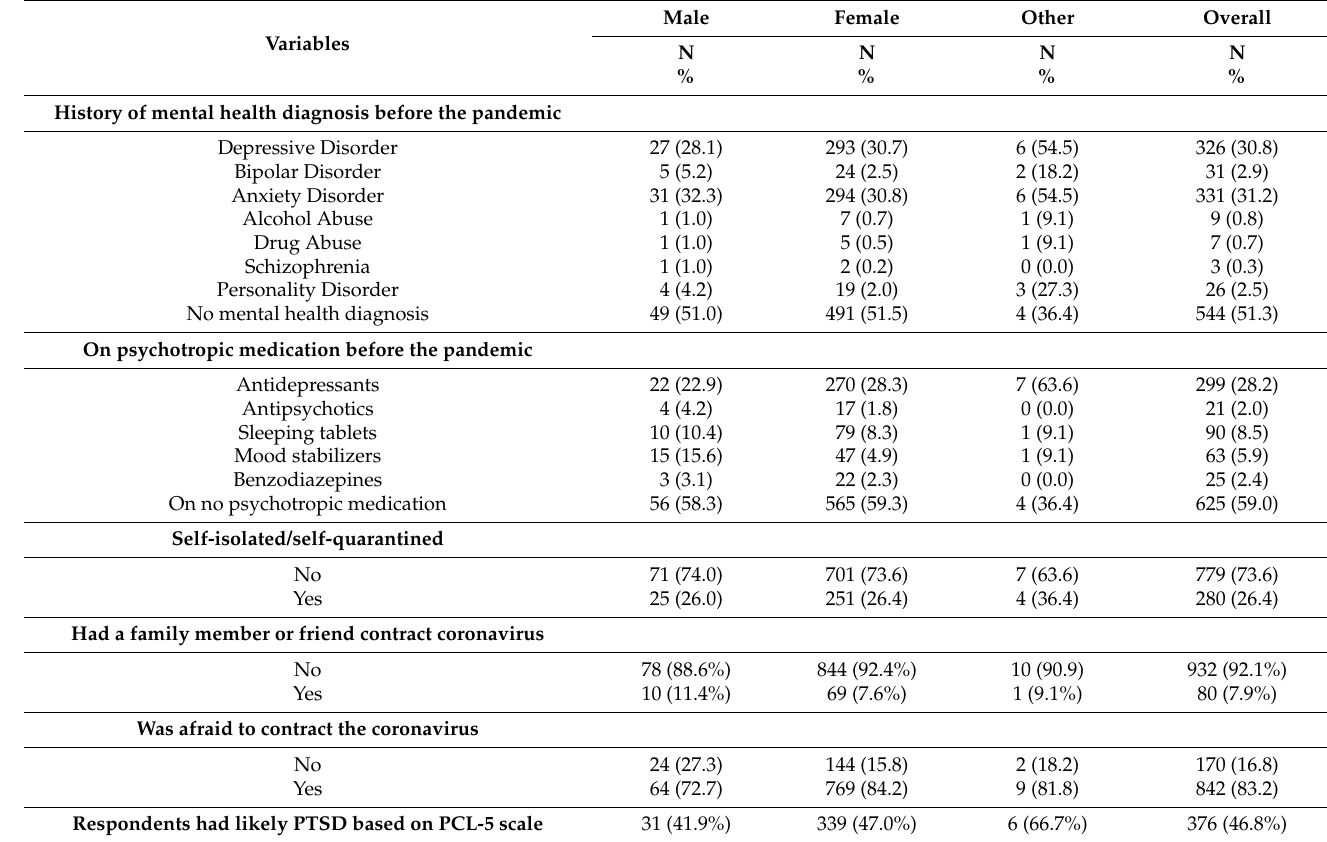
Table 2. Psychiatric history and clinical self-report-based characteristics of respondents.